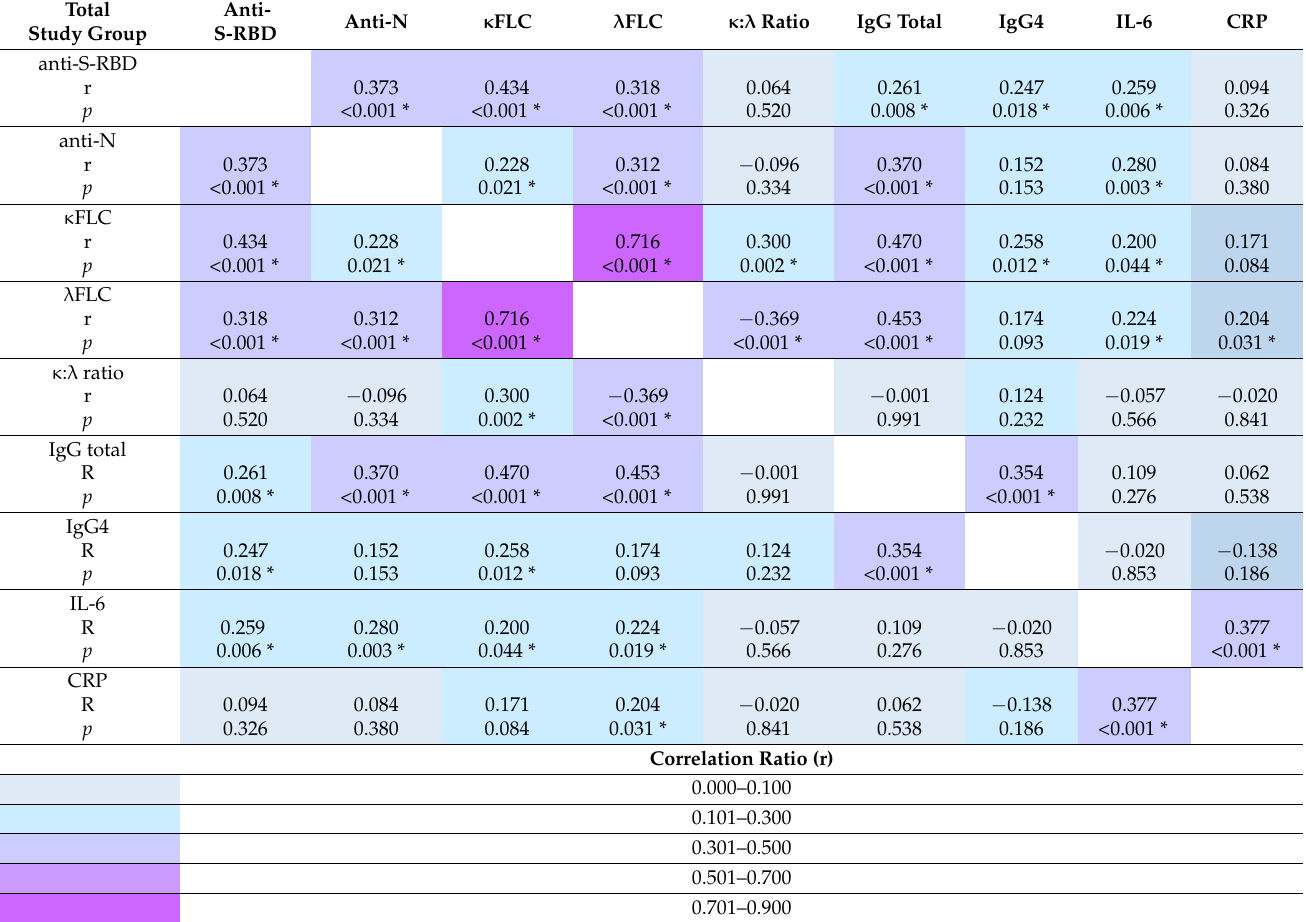
Table 4. Spearman’s correlations between tested variables in the total study